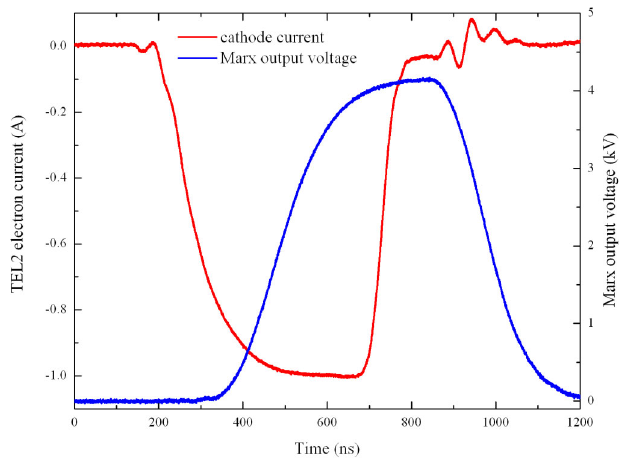
FIG. 19. (Color) TEL-2 Marx generator output voltage and electron-beam current.